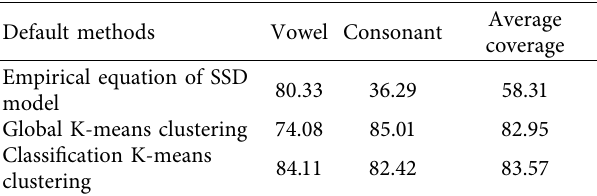
Figure 4: Broken line statistics of K-means clustering in two types. Table 1: Average coverage contrast of default parameter setting results